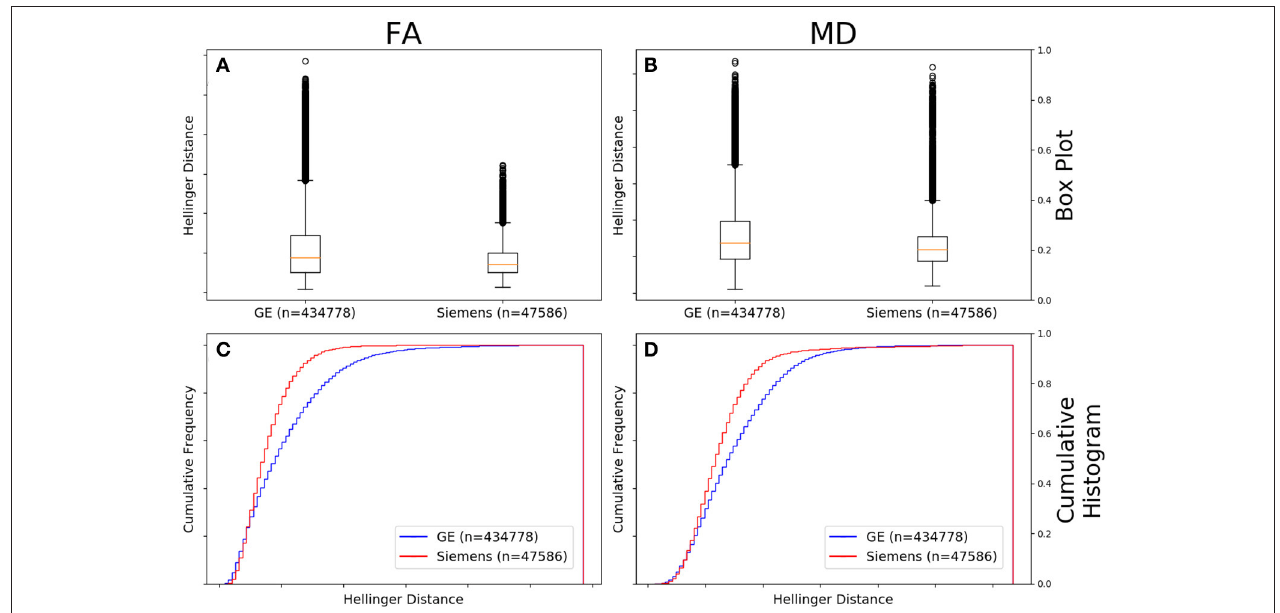
FIGURE 4 | FA (A) and MD (B) map box-and-whisker plot of the histogram distance values for all GE (number of comparisons = 434,778) vs. all Siemens (number of comparisons = 47,586). Cumulative histograms for these data are shown for FA (C) and MD (D) .